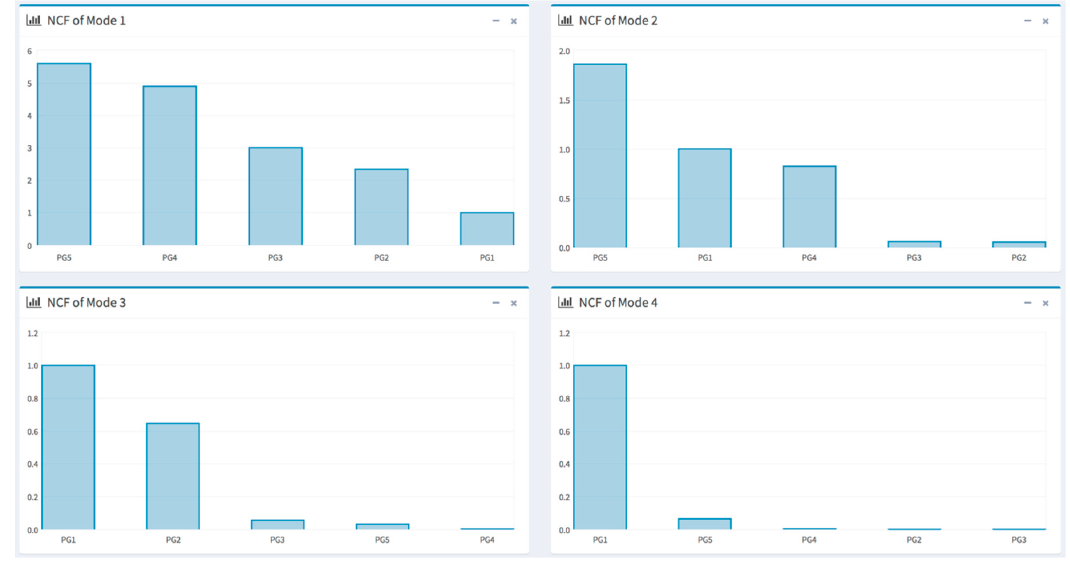
Figure 13. Contribution factors of the generators G1 to G5 of the studied third system in modes 1-4. Table 5. NCF Matrix in Test Case 3.